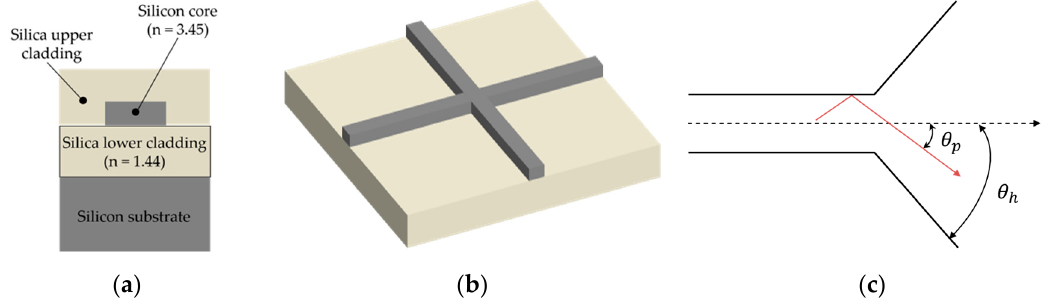
Figure 1. ( a ) Cross section of a typical silicon photonic wire waveguide. The grey structure represents the material silicon and the tawny one represents the material silica. The following schematic figure obeys the same rule. ( b ) Scheme of the direct silicon waveguide crossing on silicon-on-insulator (SOI) platform. ( c ) The ray model of the fundamental mode in the waveguide. θ p is the light projection angle and θ h is the horn angle of the optical waveguide.